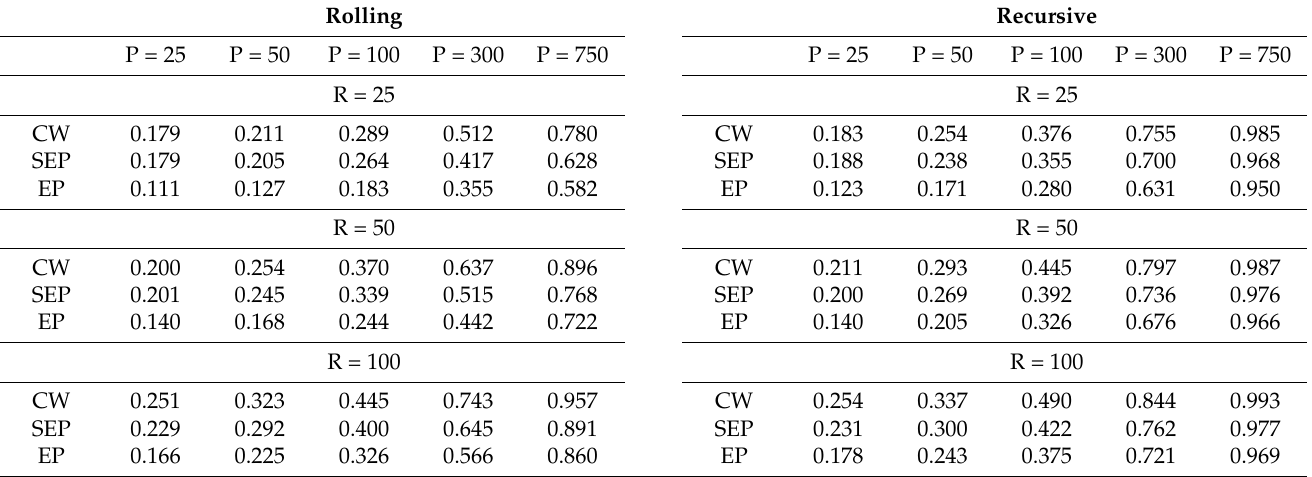
Table 7. Raw Power DGP4 (Nominal Size of 10%).